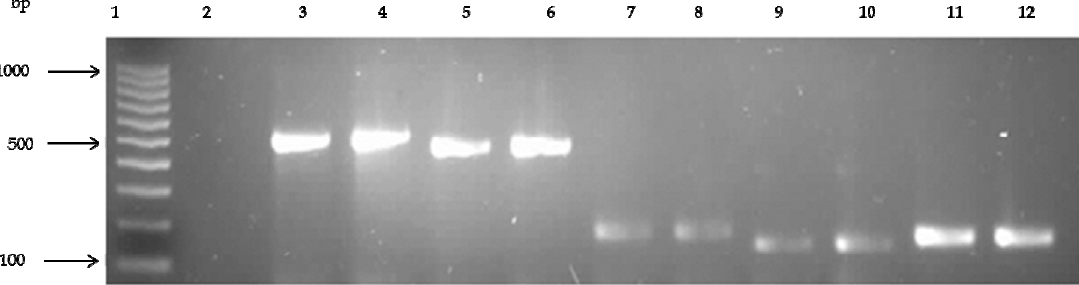
Figure 3. Representative gel showing PCR amplified products of antibiotic resistance genes of mec A, rpo B, bla Z , erm B and tet M separated on 1.5% agarose. Lane 1: 100 bp DNA ladder (Fermentas